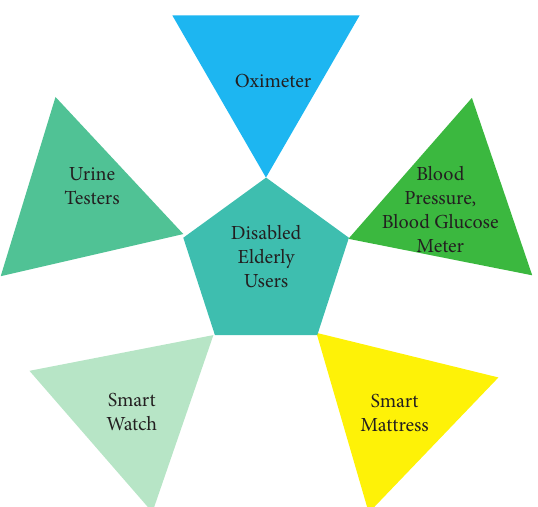
Figure 4: Some of the Internet health component devices for el- derly people with